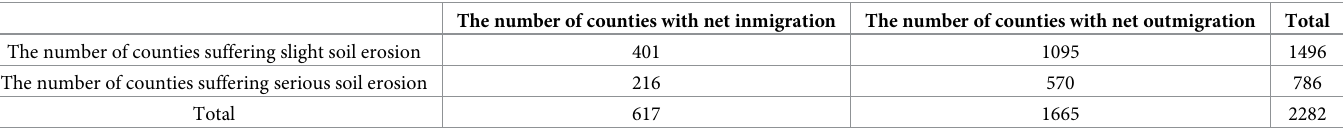
Table 1. Results of the spatial matching.